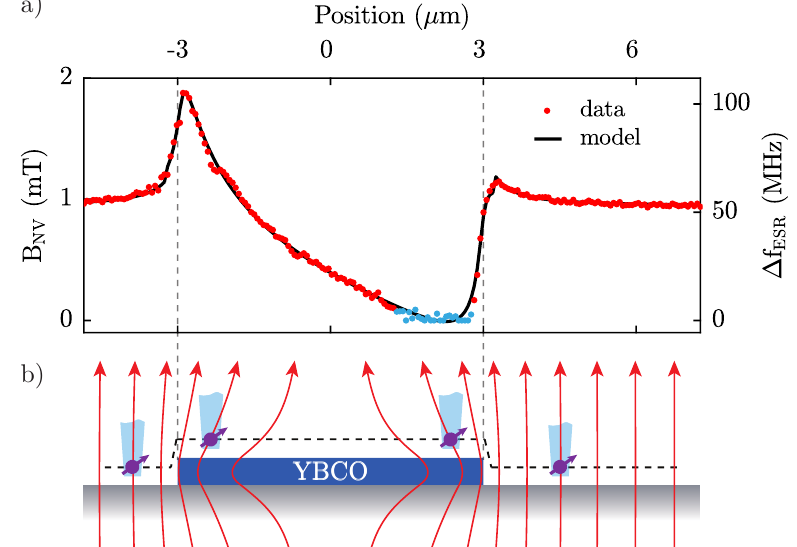
Figure 3. ( a ) Measurement of B NV across the YBCO disk along the trajectory indicated in Figure 2a. The black line in ( a ) shows the fit with the numerical model which yields a penetration depth of λ = 249 ± 5 nm. Data points marked in blue were excluded from the fit (see text). The data integration time was 24 s per point resulting in 80 min for the entire scan. A laser power of 470 µ W and a microwave power of ∼ 15 dBm were applied to the NV spin. ( b ) Magnetic field lines around the YBCO disk in the Meissner state, along with a sketch of the experimental setup. The field lines together with the NV spin quantisation direction (purple arrows) highlighted for various positions illustrate the asymmetry in B NV observed in the data. The dashed line illustrates the topography of the scan which is taken into account in the calculation of B NV